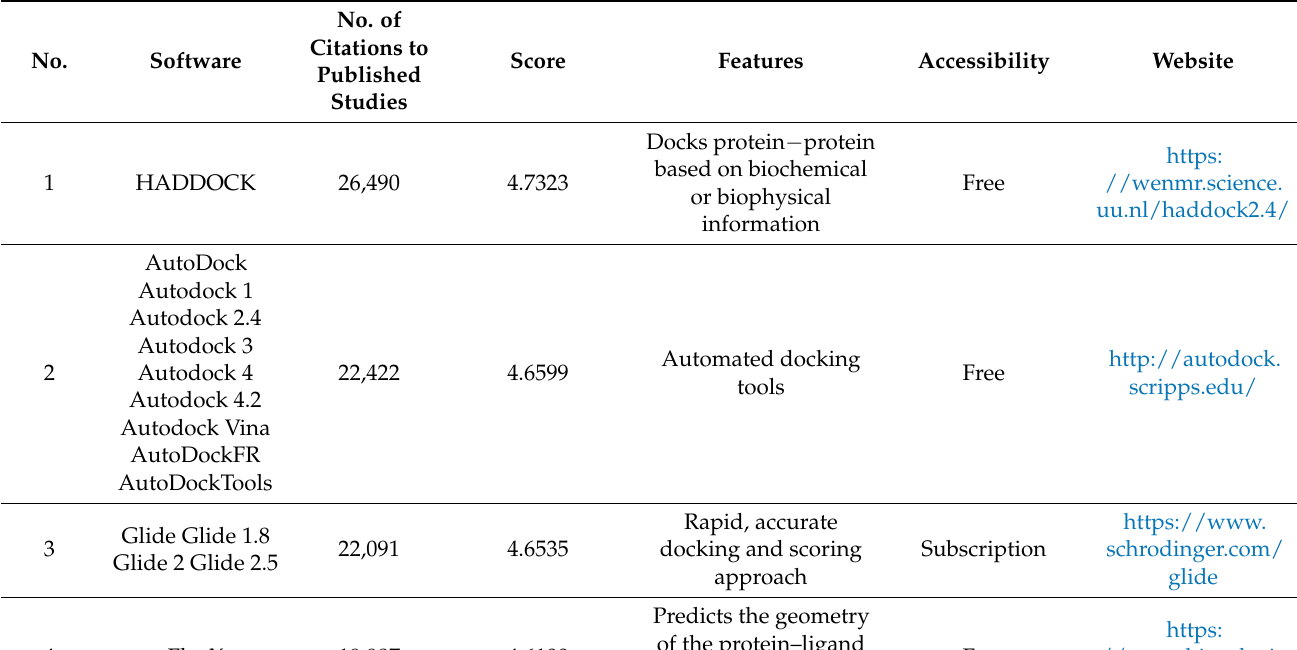
Table 1. The 30 most highly-scored pieces of software for CADD. Software was ranked according to the equation S i = log(10 6 .C i /C total ) where S i is the score for tool i , C i is the number of citations to tool i , and C total is the number of citations to all tools considered. Number of citations was obtained using Google Scholar, last accessed on 14 April